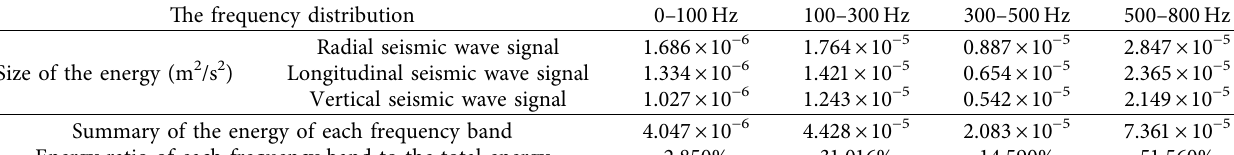
Table 2: Energy values of typical seismic wave signals in each frequency